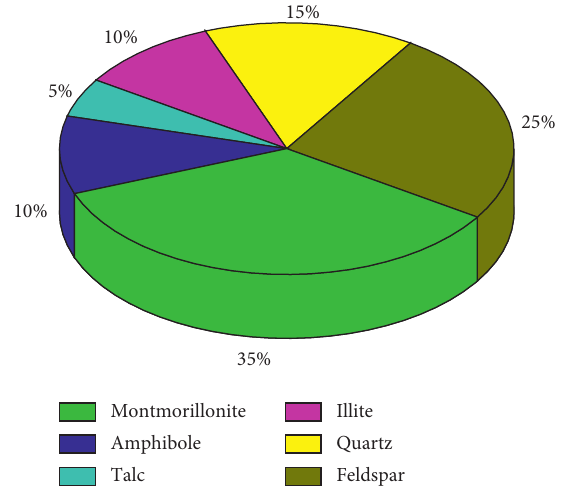
Figure 5: Analysis results of mineral composition of sandy